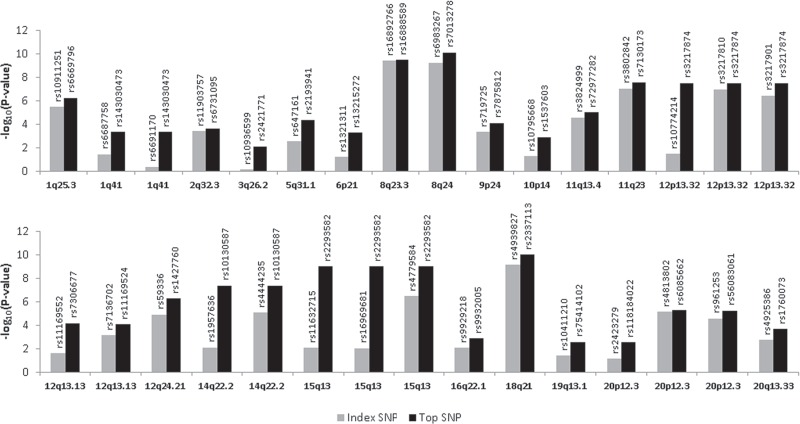
Comparison of P-values for GWAS-identified variants (index SNPs) vs. variants with the smallest P-values (top SNPs) in 31 regions.The height of each bar reflects the–log10 P-value of each SNP in our study population. A grey bar indicates the index SNP, and a black bar indicates the top SNP.